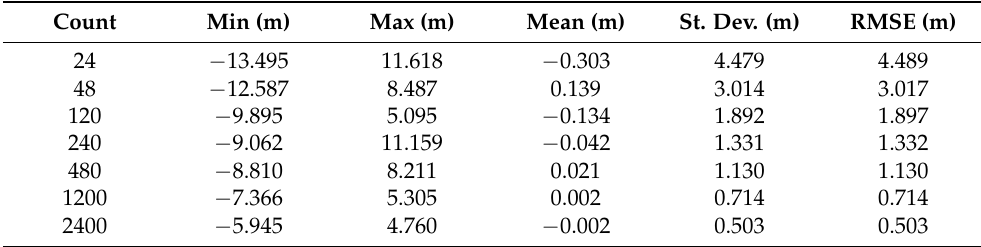
Table 1. Statistical terms of the residuals supplied by cross-validation for the Ordinary